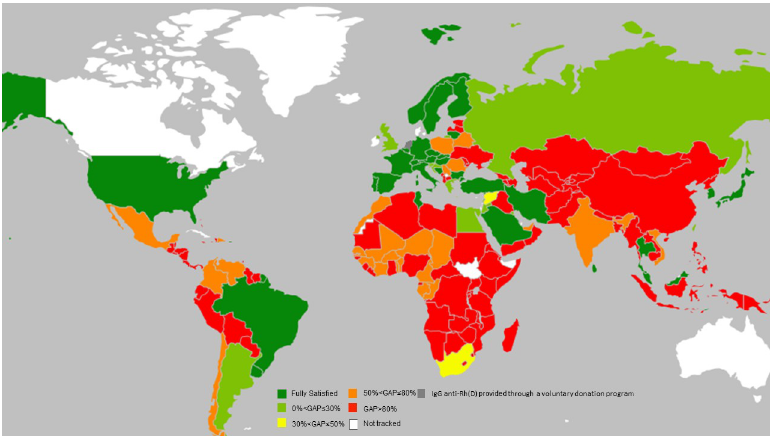
Fig 2. Heat-map representing each country’s gap in providing post-partum Rh(D) immunoprophylaxis. The “gap” is the proportion of annual doses of IgG anti-Rh(D) not administered post-partum divided by those that should have been administered to prevent maternal Rh(D) sensitization. The size of the gap is indicated by various colors; dark green: fully satisfied; light green: gap between 0 and 30%; yellow: gap between 30 and 50%; light orange: gap between 50 and 80%; dark orange: gap greater than 80%; white: data not available because statistics are not tracked in these countries; gray: IgG anti-Rh(D) provided through a national volunteer program [22] and, therefore, not tracked in the MIDAS